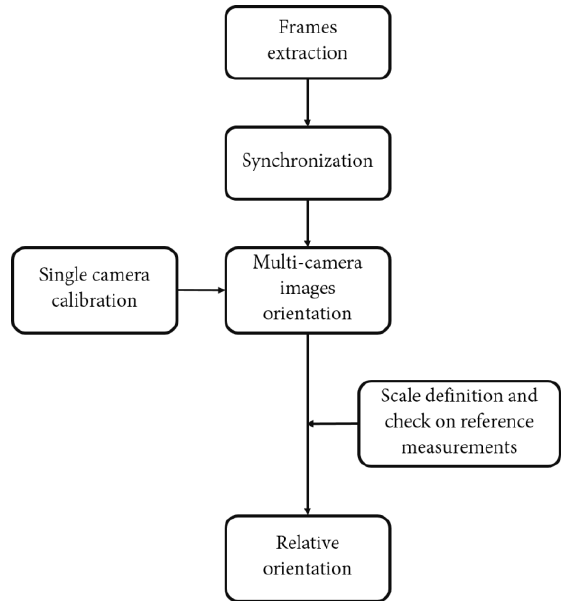
Figure 2. Flow-chart of the implemented procedure for the computation of RORE between the GoPro